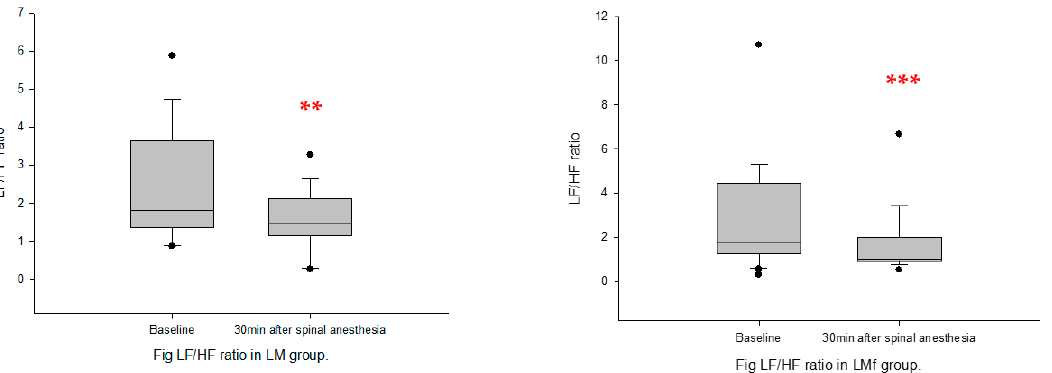
Figure 4. DFA α 1 ratio at baseline and post-general anesthesia for Group P (propofol); D: Group D (desflurane). Box plots showing the median, 10th, 25th, 75th, and 90th percentiles as vertical boxes with error bars and plot all data points outside the 10th and 90th percentiles as black circle dots. The significance levels with paired t -tests between baseline and successive measurement periods are as follows: * p < 0.05; *** p < 0.001.